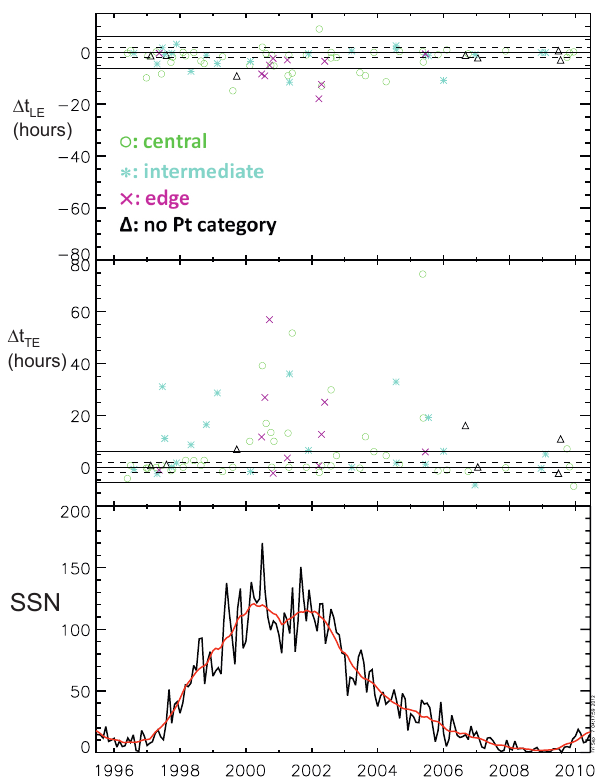
Fig. 3. Differences in ICME and MC leading edge times (top panel) and trailing edge times (middle panel). The bottom panel shows the (black) monthly and (red) monthly smoothed sunspot numbers from the Solar Influences Data Center. In the two top panels we have subtracted ICME leading and trailing edge times from the MC leading and trailing edge times. Horizontal lines show ± 2 and ± 6h that we have used as thresholds to mark the cases where boundary times agree or differ significantly. The different symbols indicate the spacecraft’s closest approach distance (given in the UCLA list) from the MC center as estimated from the perpendicular pressure profile (green circle: central cut, light-blue star: ICME crossed from the intermediate distances from the center, purple X: ICME flanks encountered, black triangle: P t category could not be